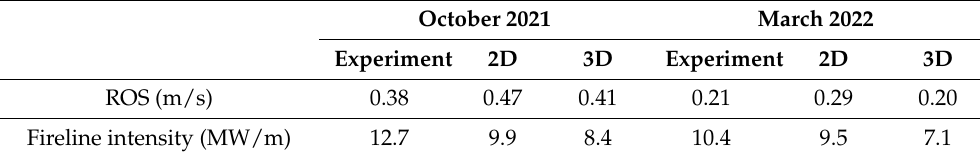
Figure 5. Variation with time of the fire front position as well as the heat release rate during the experiments conducted in October 2021 and March 2022, evaluated using FireStar3D. Table 2. Experimental and numerical values of ROS and fireline intensity obtained using FireStar2D and FireStar3D.